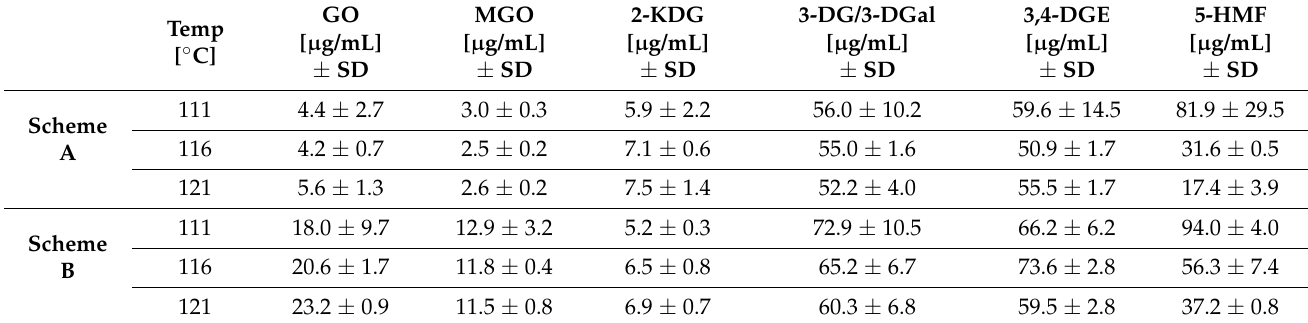
Table 4. Concentrations of GDPs in 10% ( w / v ) glucose solution in PP bottles autoclaved according to scheme A ( n = 27).